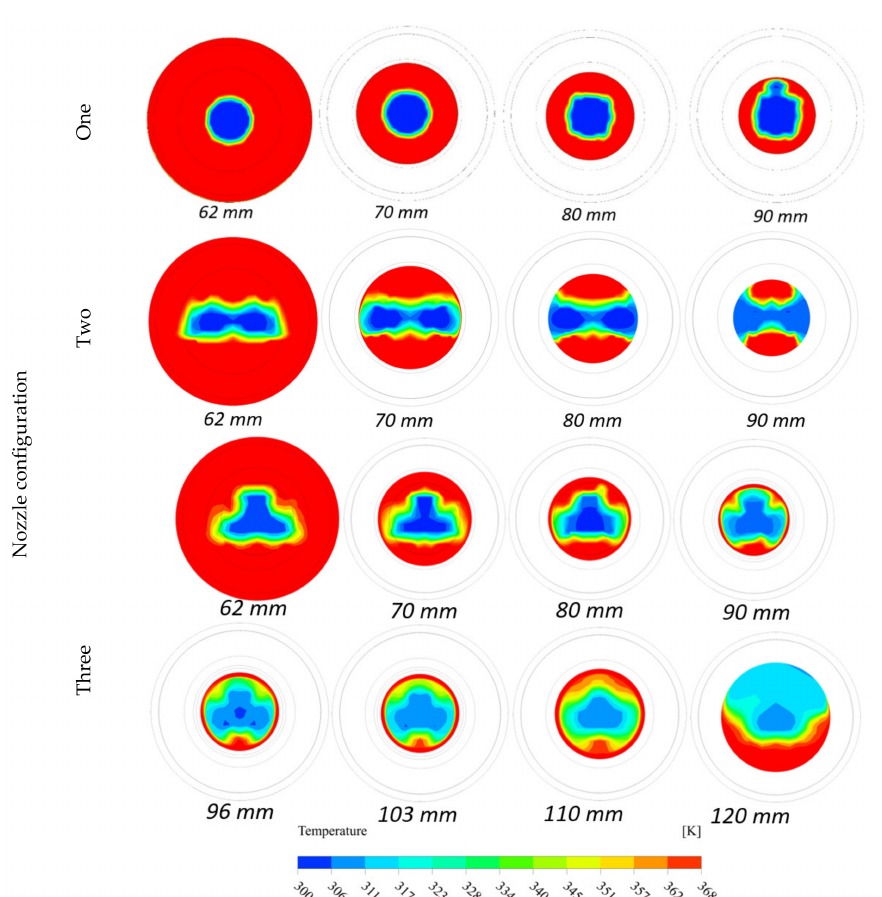
Figure 17. Radial distribution of temperature at different axial positions.